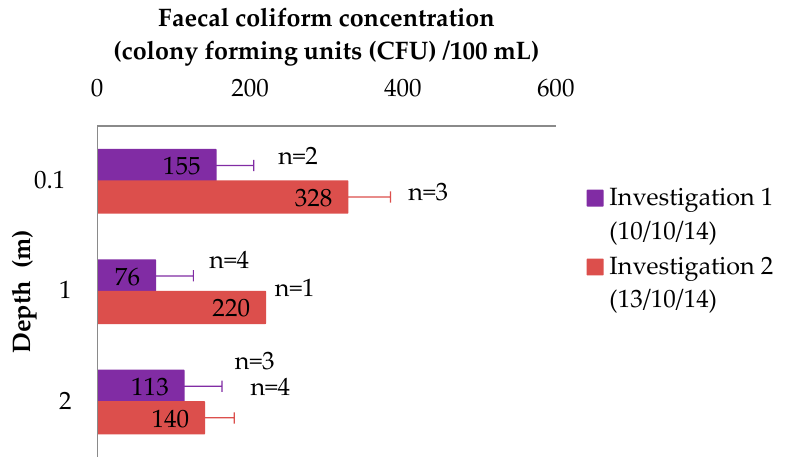
Figure 3. Faecal coliform concentration measured at different pond depths.